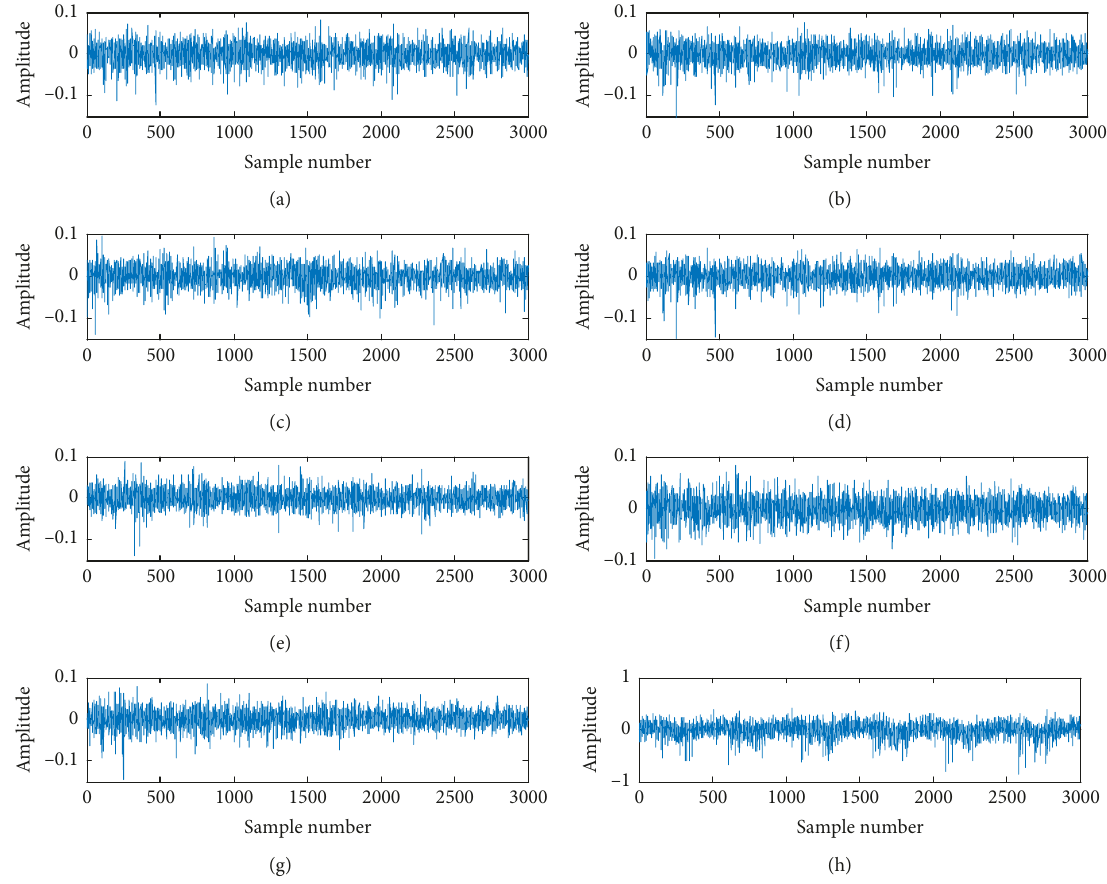
Figure 30: Multiresolution DMD modes of the wear gear fault signal.